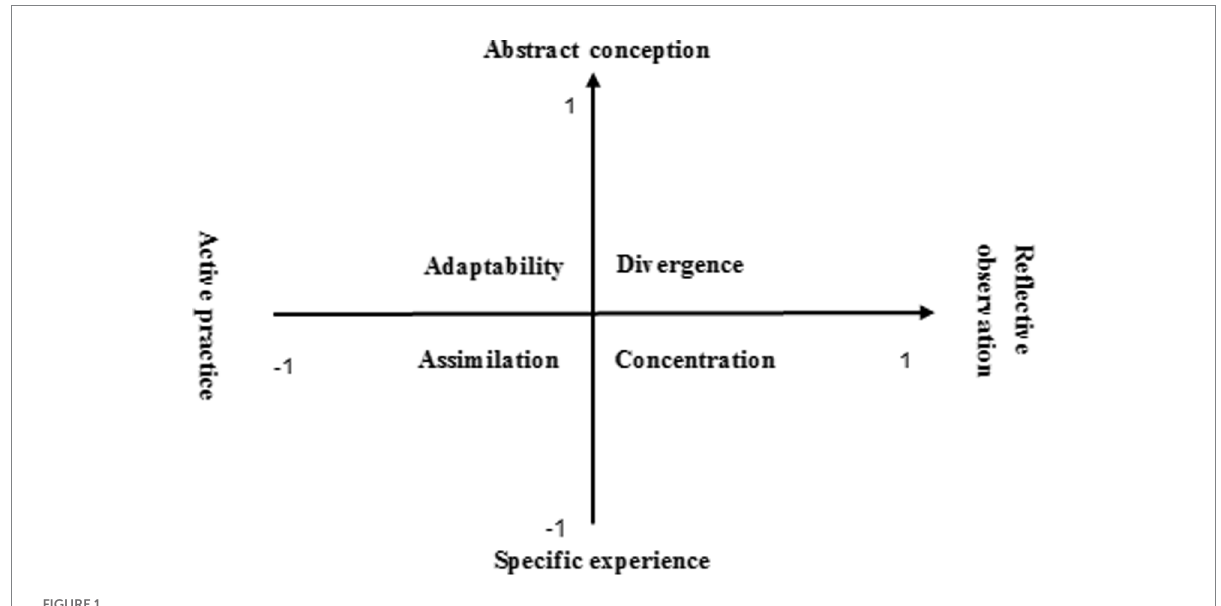
FIGURE 1 Kolb learning style